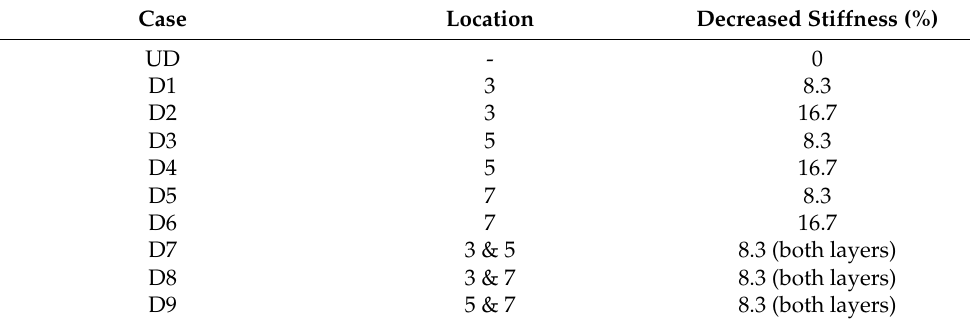
Table 1. Description of different damage cases